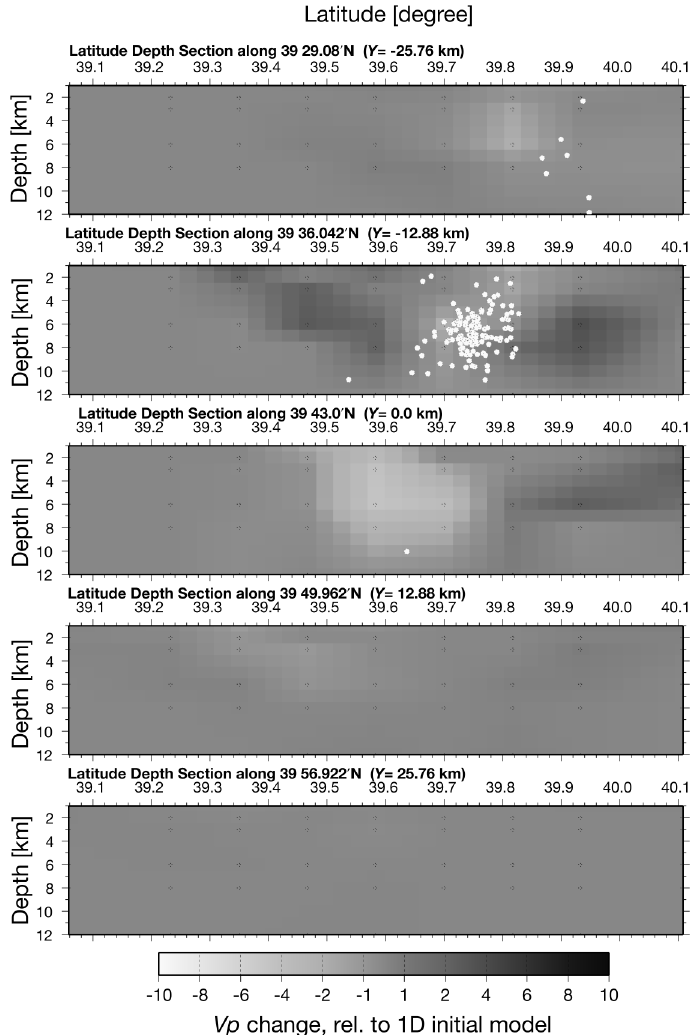
Fig. 4. S-N vertical depth sections of the percentage P -wave velocity change along the profiles of constant longi- tudes selected at equal degrees for the model. The constant longitudes values are shown at the top of each